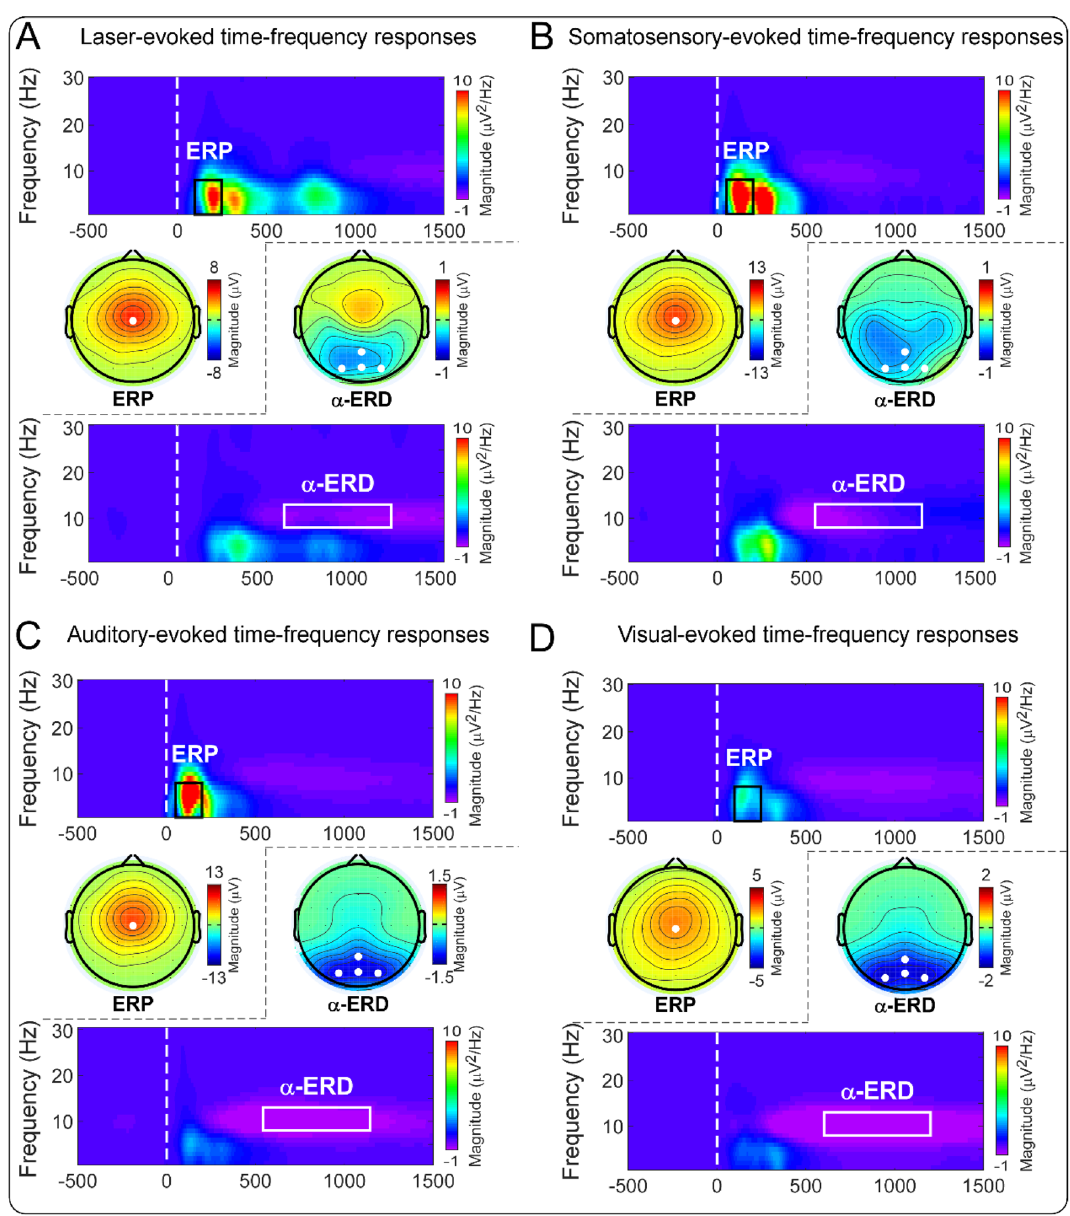
Figure 4. Group-level time–frequency distributions and scalp topographies of ‘ERP’ and ‘α-ERD’ responses elicited by nociceptive somatosensory, non-nociceptive somatosensory, auditory, and visual stimuli. Group- level TFDs and scalp topographies of the ‘ERP’ and ‘α-ERD’ responses elicited by nociceptive somatosensory, non-nociceptive somatosensory, auditory, and visual stimuli are displayed from ( A – D ). Regardless of sensory modality, transient stimuli elicited both phase-locked (‘ERP’: 100–250/50–200 ms, 1–8 Hz, central electrode) and non-phase-locked brain responses (‘α-ERD’: 600–1200/550–1150 ms, 8–13 Hz, parietal-occipital